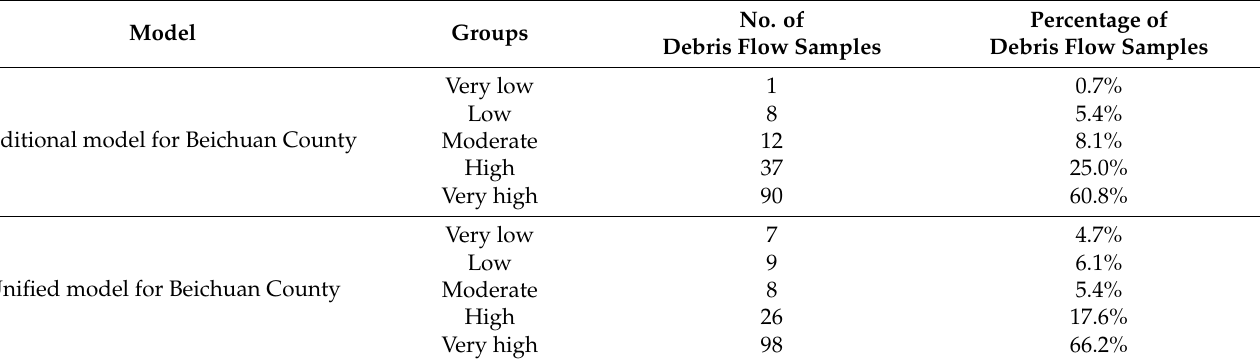
Table 2. The sample statistical results of different